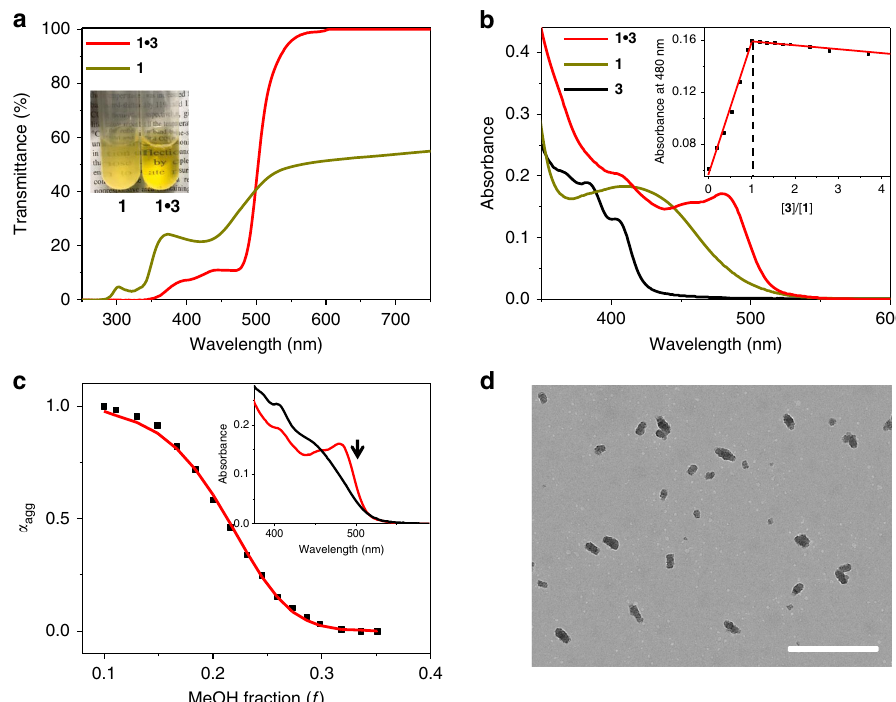
Fig. 3 Characterization of co-assembled system from 1 (cid:129) 3 . a Ultraviolet – visible (UV ‒ Vis) transmittance spectra of 1 and 1 (cid:129) 3 in pure water (5.00 × 10 − 5 M for each compound). Inset: images of 1 and 1 (cid:129) 3 in pure water (5.00 × 10 − 5 M for each compound). b UV ‒ Vis spectra of 1 , 3 , and complex 1 (cid:129) 3 (0.05 mM for each compound) in water/MeOH (90:10, v / v ). Inset: molar ratio plot for complex 1 (cid:129) 3 , by monitoring the absorption intensity at 480 nm. c Degree of aggregation ( α agg ) as a function of MeOH volume fraction monitored at 480 nm. The red line denotes the mathematical fi tting of the curve according to the solvent-dependent equilibrium model (see Eqs. (1) and (2) in “ Methods ” ). Inset: solvent-dependent UV – Vis absorption spectra of 1 (cid:129) 3 [5.0 × 10 − 5 M for each compound in water/MeOH (from 90:10 to 65:35, v / v )]. The arrow indicates the spectral changes upon increasing the MeOH fraction. d Transmission